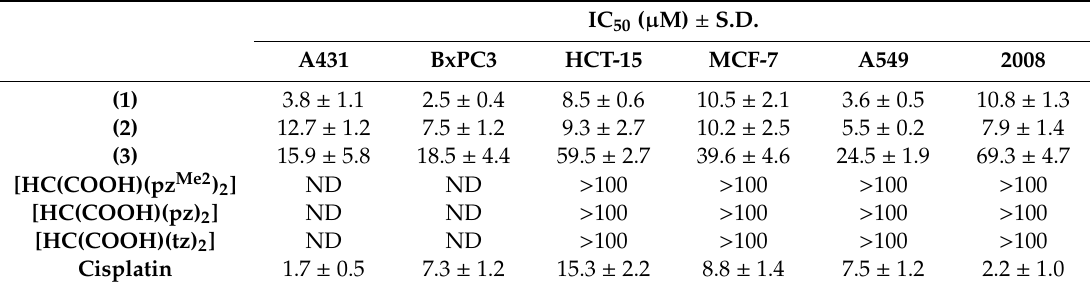
Table 2. Cytotoxic